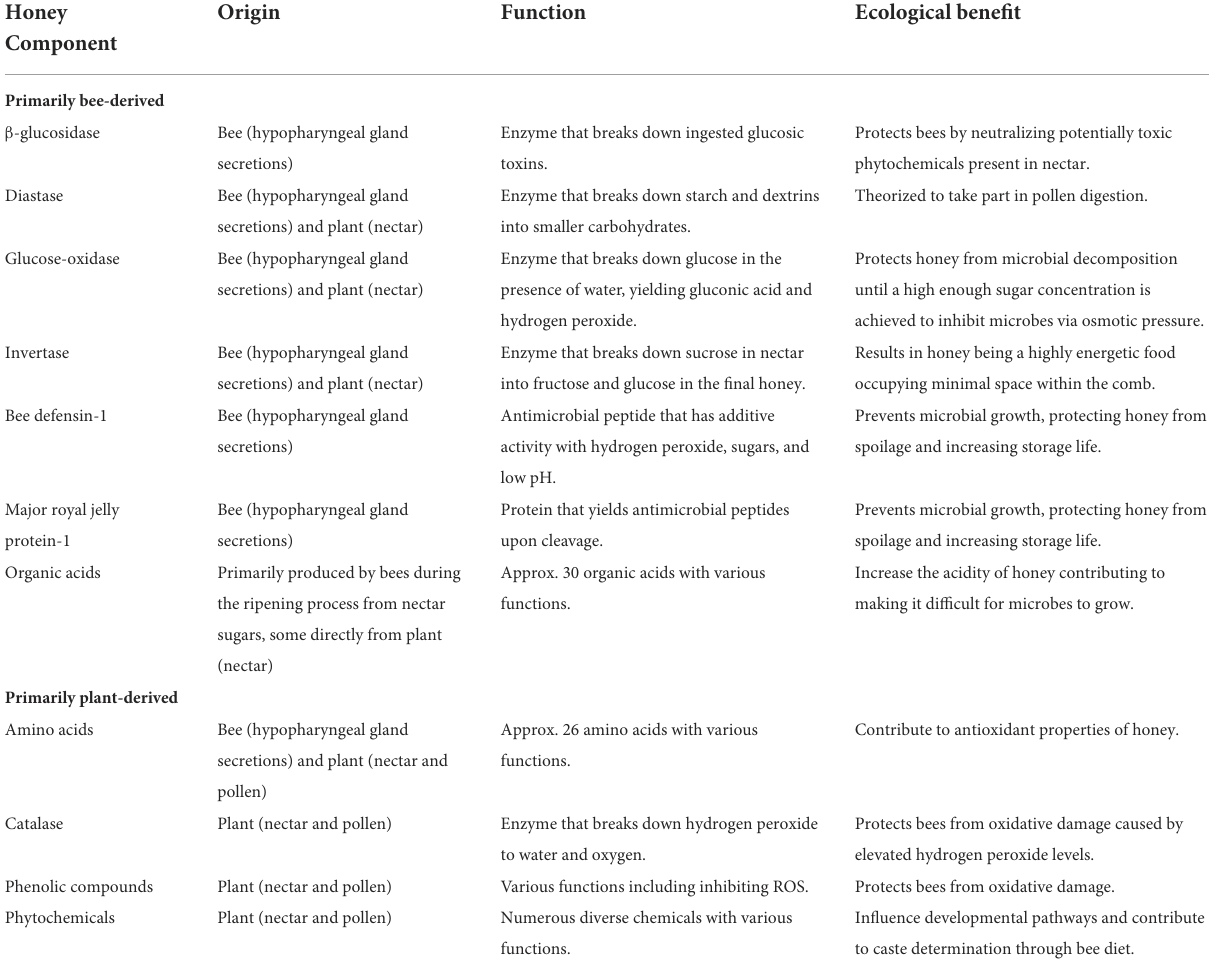
TABLE 1 Ubiquitous honey components and their ecological benefit to the